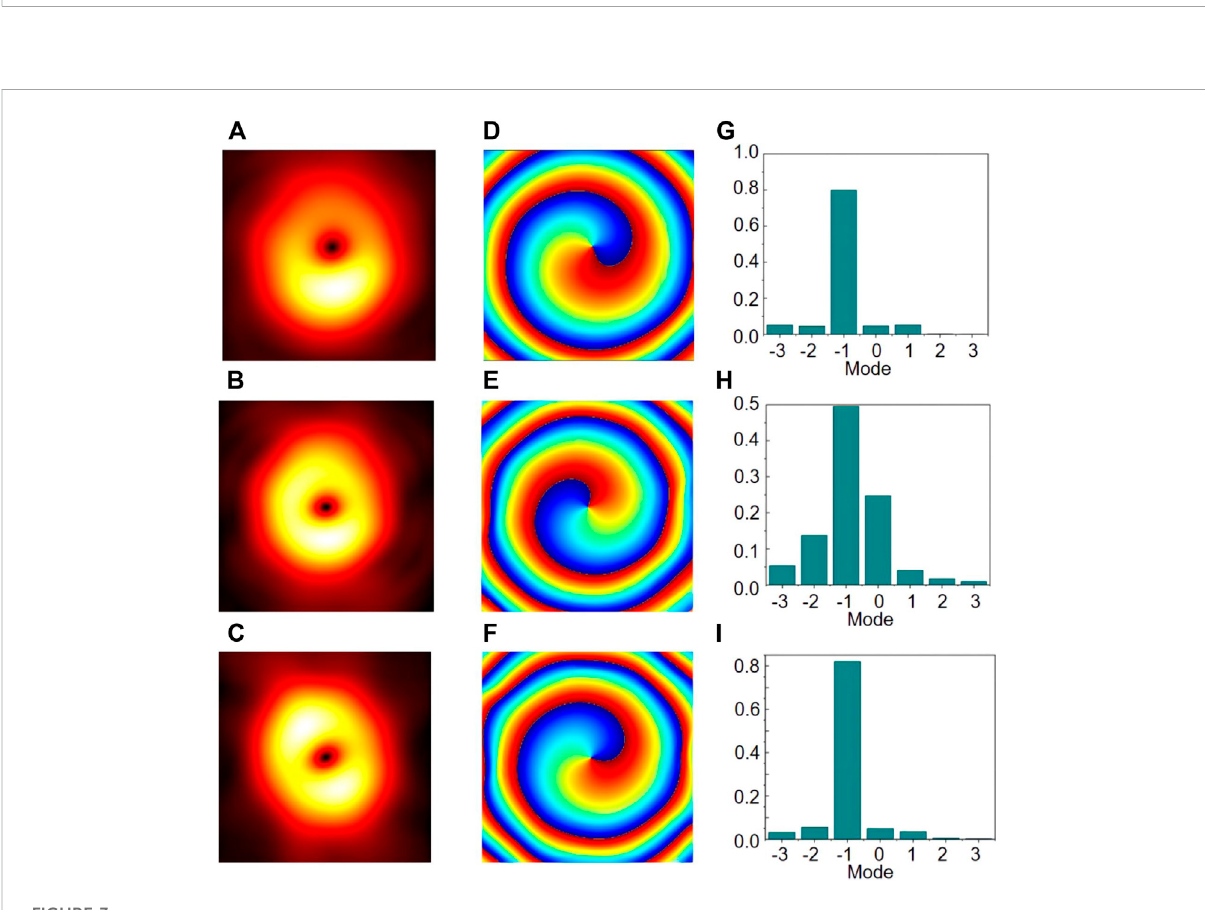
FIGURE 3 (A – C) The amplitude distribution and (D – F) the phase delay distribution and (G – I) the OAM spectrum of the simulated re fl ect wave at 8 GHz, 10 GHz and 12 GHz,